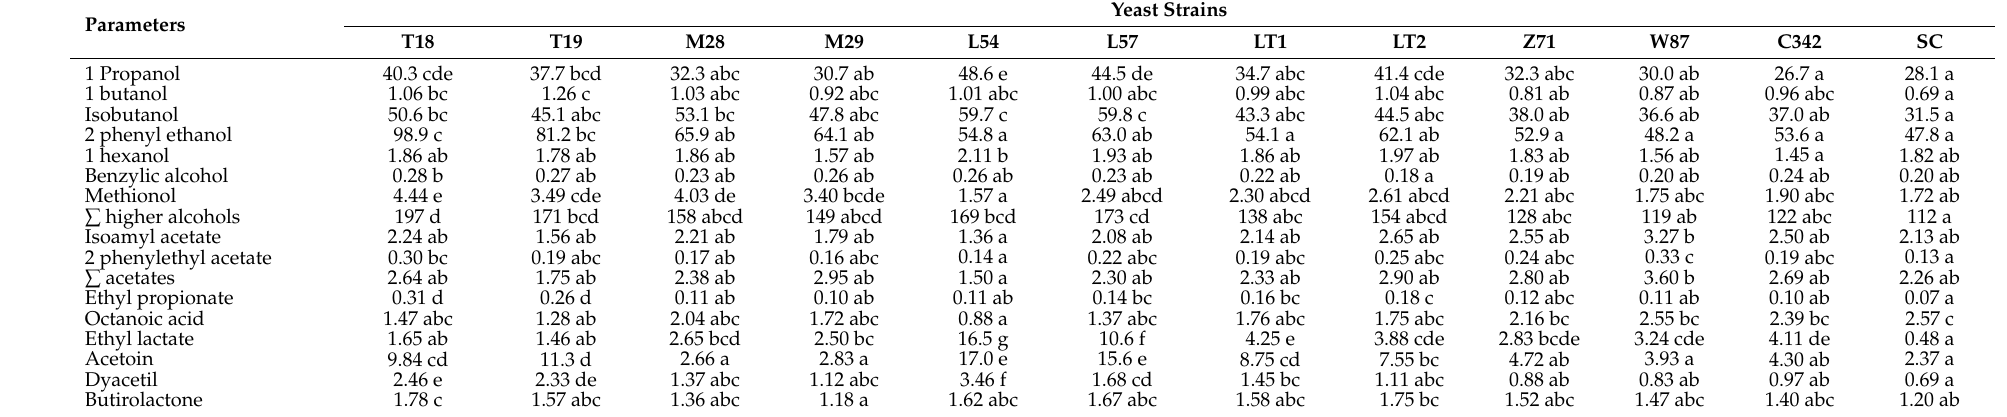
Table 5. Aromatic compounds (mg/L) with significant differences in wines sequentially fermented with different non- Saccharomyces yeasts and S. cerevisiae at the end of alcoholic fermentation